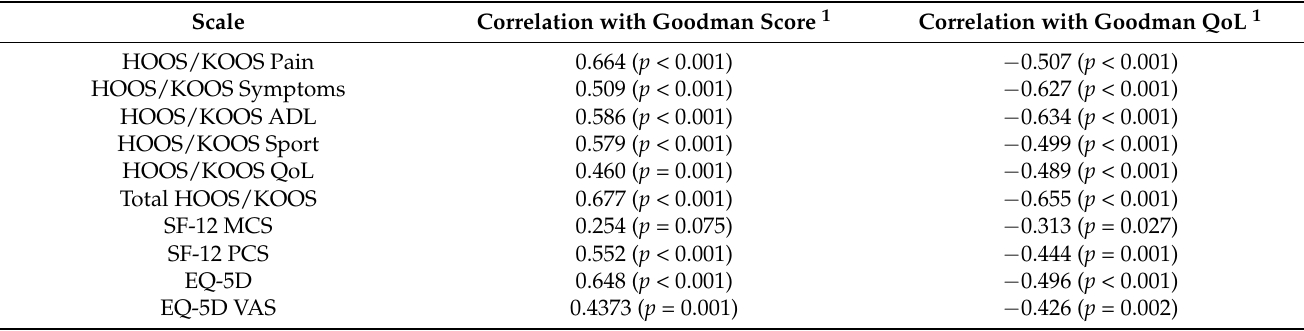
Table 1. Correlation between Goodman score and Goodman QoL and validated PROMs.